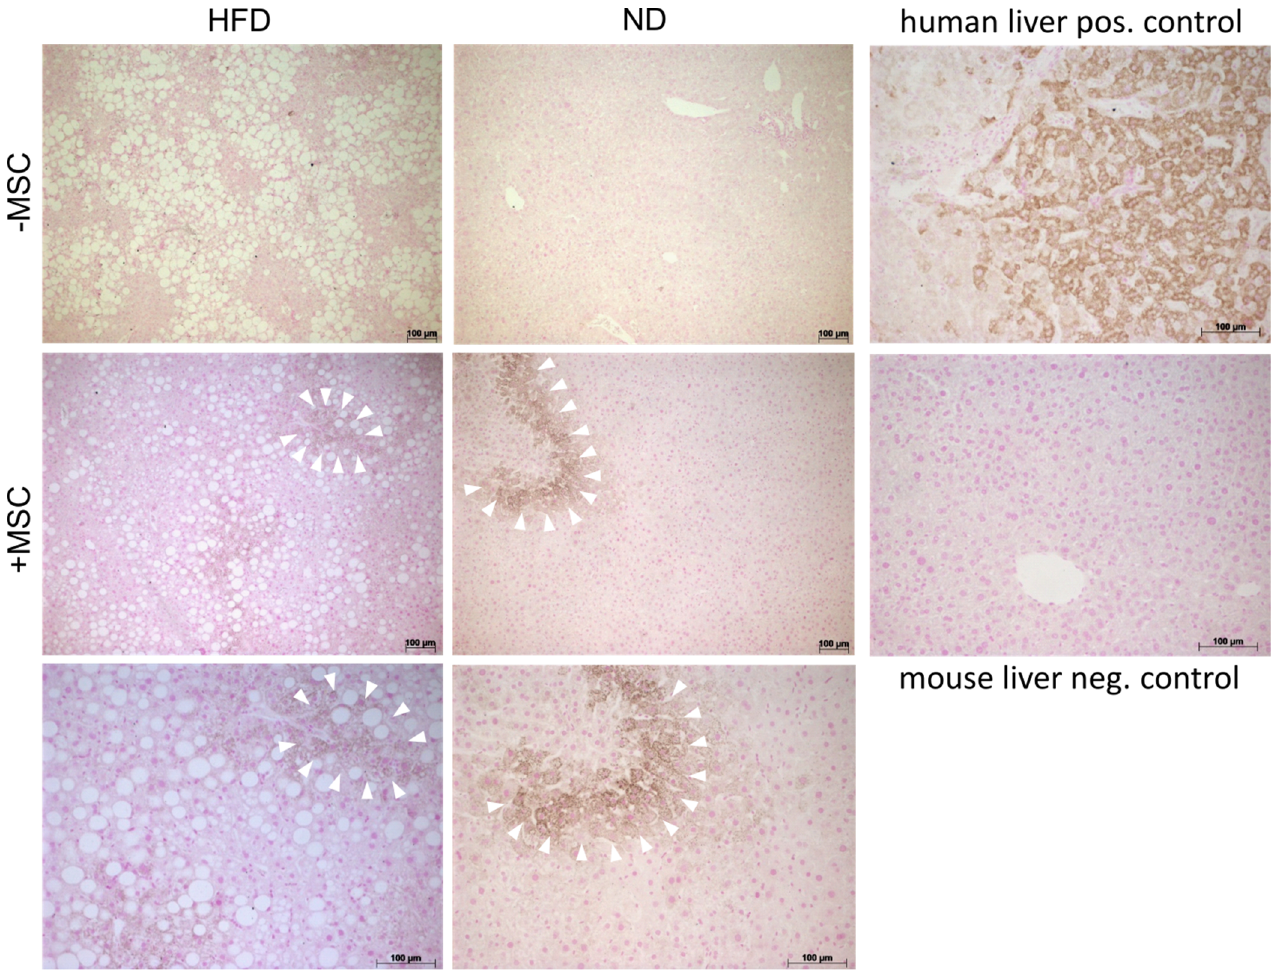
Figure 4. Human donor MSC in recipient livers of high-fat-diet-fed mice. Immunohistochemical detection of carbamoylphosphate synthetase 1 in human MSC transplants using the anti-human specific HepPar1 antibody reveals a patchy localization of the transplanted MSC (+MSC) both in livers without (ND) and with NASH (HFD). White arrowheads in the middle and bottom panels demarcate areas in the mouse parenchyma harboring transplanted human MSC. Bottom panels show higher magnifications (orig. mag. 20×) of the panels above (orig. mag. 10×). Pictures are representative for 3 different animals out of each group. Panels on the right show positive and negative control stainings in human and mouse liver tissue. Scale bar—100 µm.